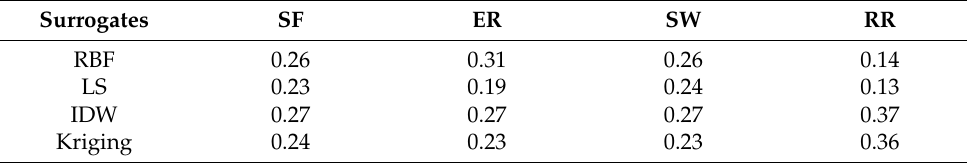
Table 2. Weights of each single surrogate